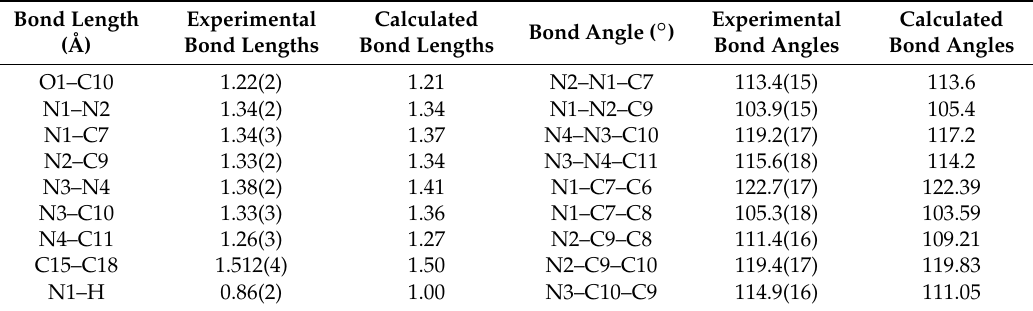
Table 2. Selected structural parameters by X-ray and theoretical calculations of compound L2 .